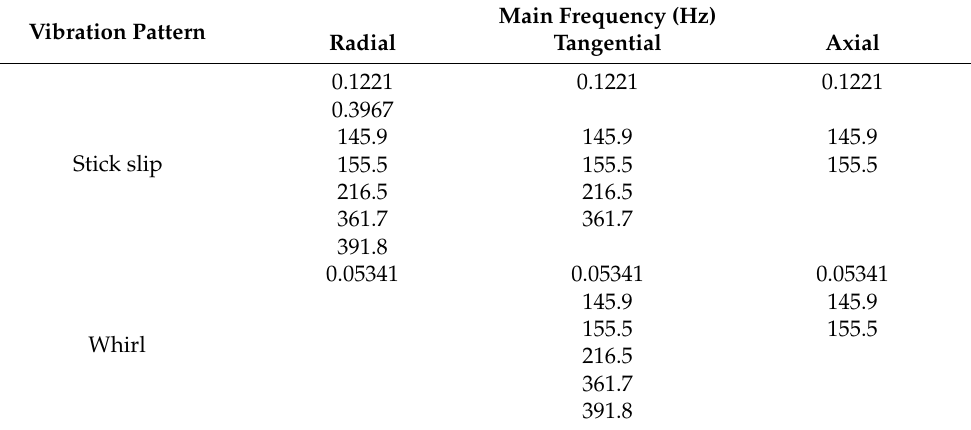
Table 6. Feature frequency statistics when different vibration patterns